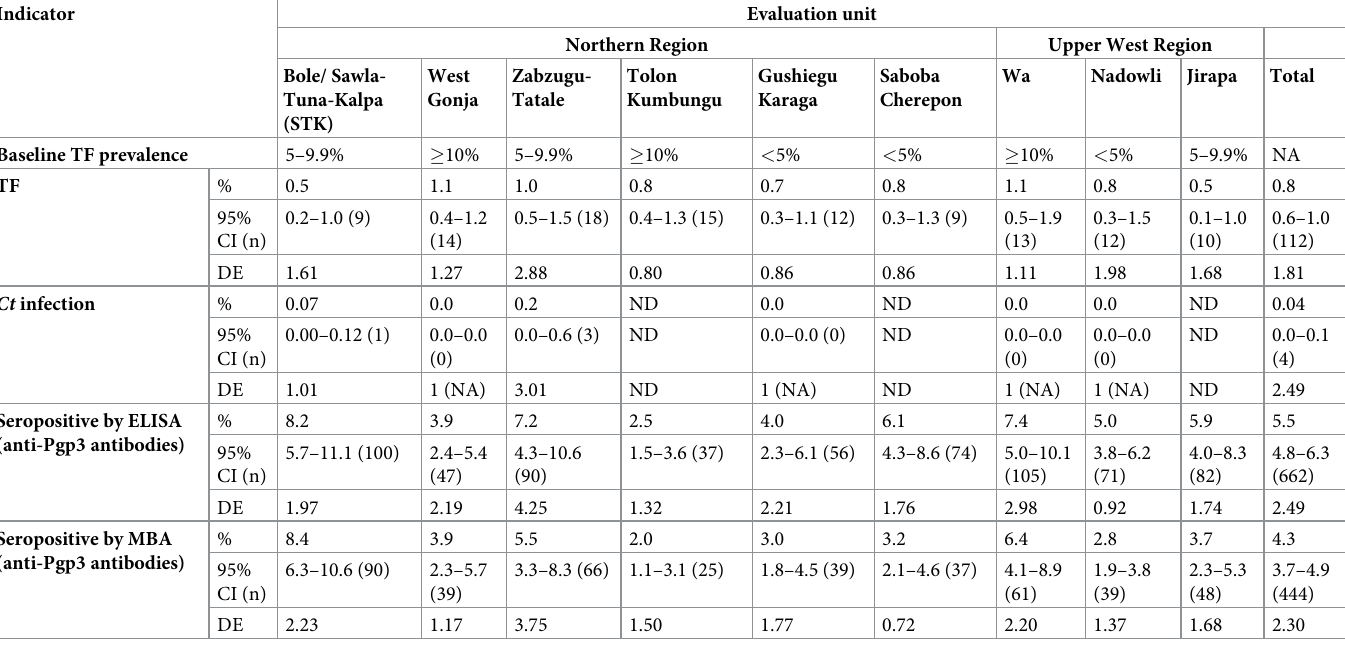
Across all EUs, 1.0% of individuals (n = 112; 95%CI: 0.8–1.2) had TF in one or both eyes; of those, 67.9% (n = 76) had bilateral TF. There was no evidence of an association between TF and age (z = -0.48; p = 0.63). No TT was identified in children. The median age of individuals with TF was 4.5 years and 53.6% were female. The overall cluster-summarised mean TF prevalence was 0.8% (95%CI:0.6–1.0), with an EU-level range of 0.5–1.1%, Table 3. Table 3. Cluster-summarised mean prevalence of trachomatous inflammation—follicular (TF), Chlamydia trachomatis ( Ct ) infection and Pgp3 seropositivity by ELISA and MBA in children aged 1–9 years across selected evaluation units in Northern and Upper West regions of Ghana.